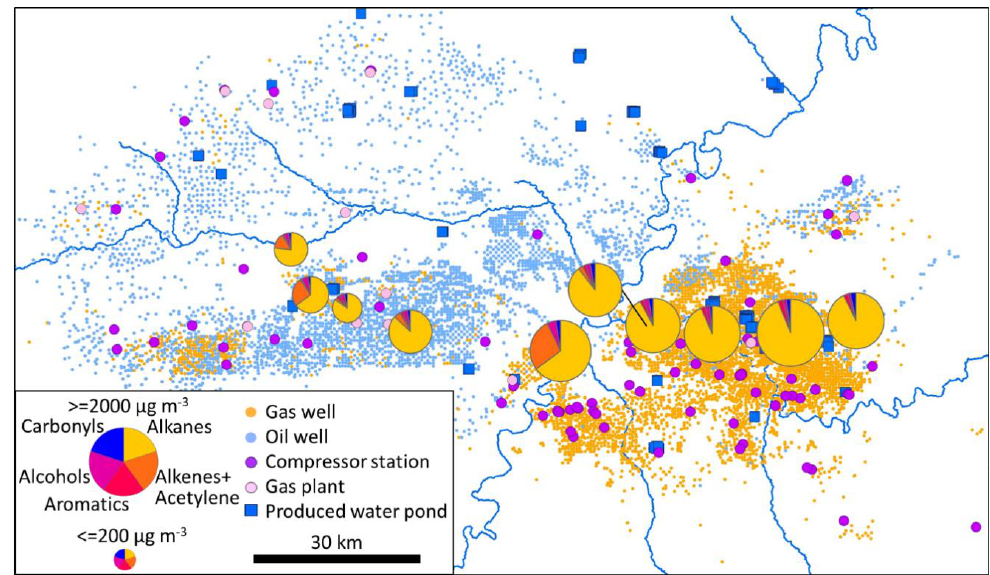
Figure 4. Composition (weight percent) and total concentration of organic compounds measured on 27 February 2019 from 10:00 to 16:00.